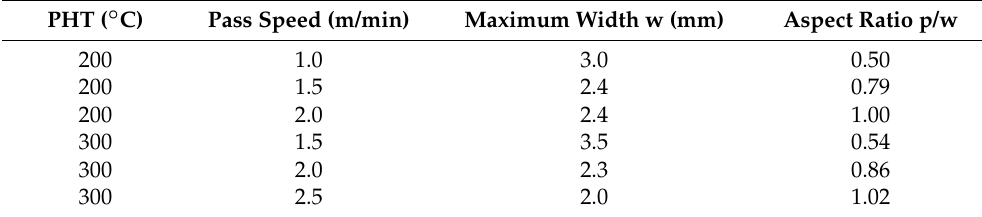
Table 2. Maximum width w and aspect ratio p/w (p: depth, w: maximum width) of the joints in different conditions of welding pass speed and pre-heating temperature (PHT).